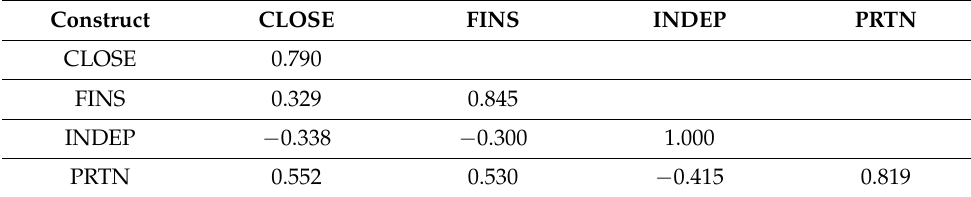
Table 5. Fornell–Larcker Criterion.